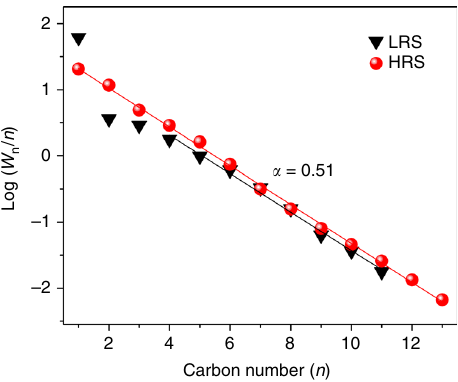
Fig. 2 ASF distribution for low and high-reactivity hysteresis branches. Obtained at a H 2 /CO partial pressure ratio of 5/1 and otherwise identical reaction conditions as in Fig. 1. W n stands for the mass fraction of